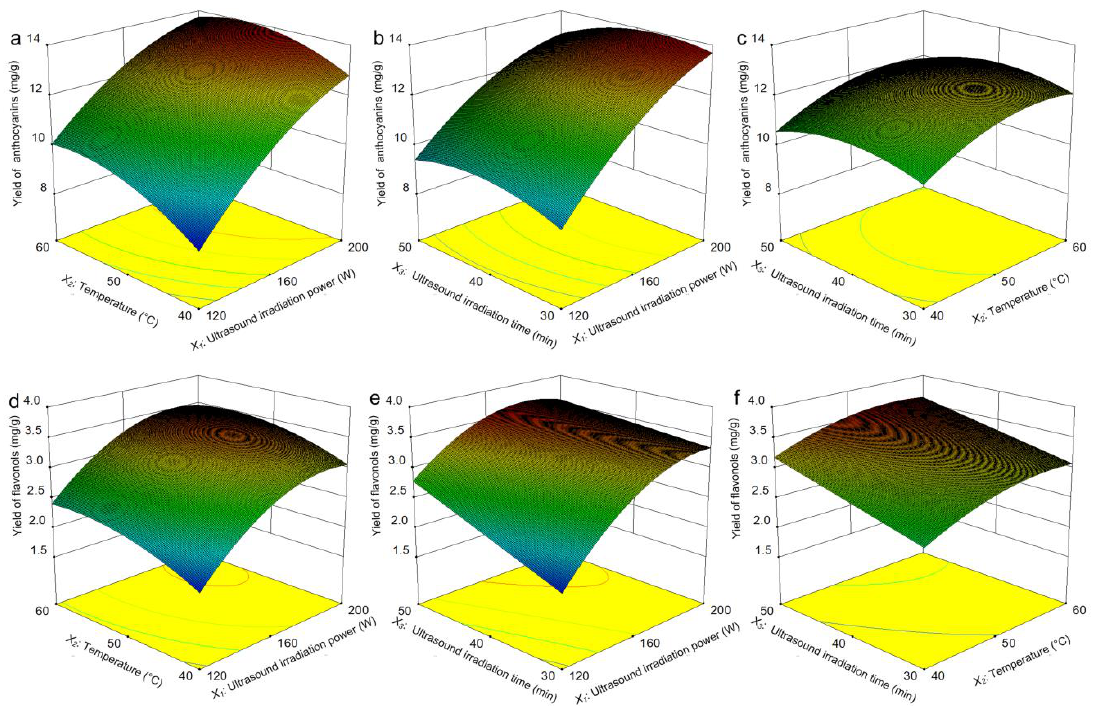
Figure 5. Optimization of the yields of anthocyanins and flavonols by response surface methodology. The e ff ect of the ultrasound irradiation power and temperature on the extraction yields of anthocyanins ( a ) and flavonols ( d ), the e ff ect of the ultrasound irradiation power and ultrasound irradiation time on the extraction yields of anthocyanins ( b ) and flavonols ( e ), the e ff ect of the temperature and ultrasound irradiation time on the extraction yields of anthocyanins ( c ) and flavonols ( f ).